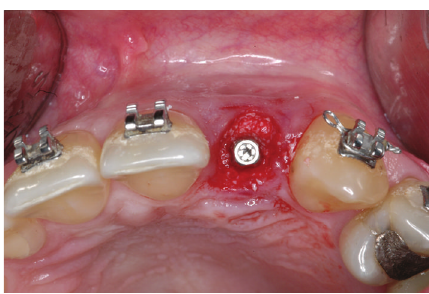
Figure 5: Peri-implant defect filled with biomaterial.